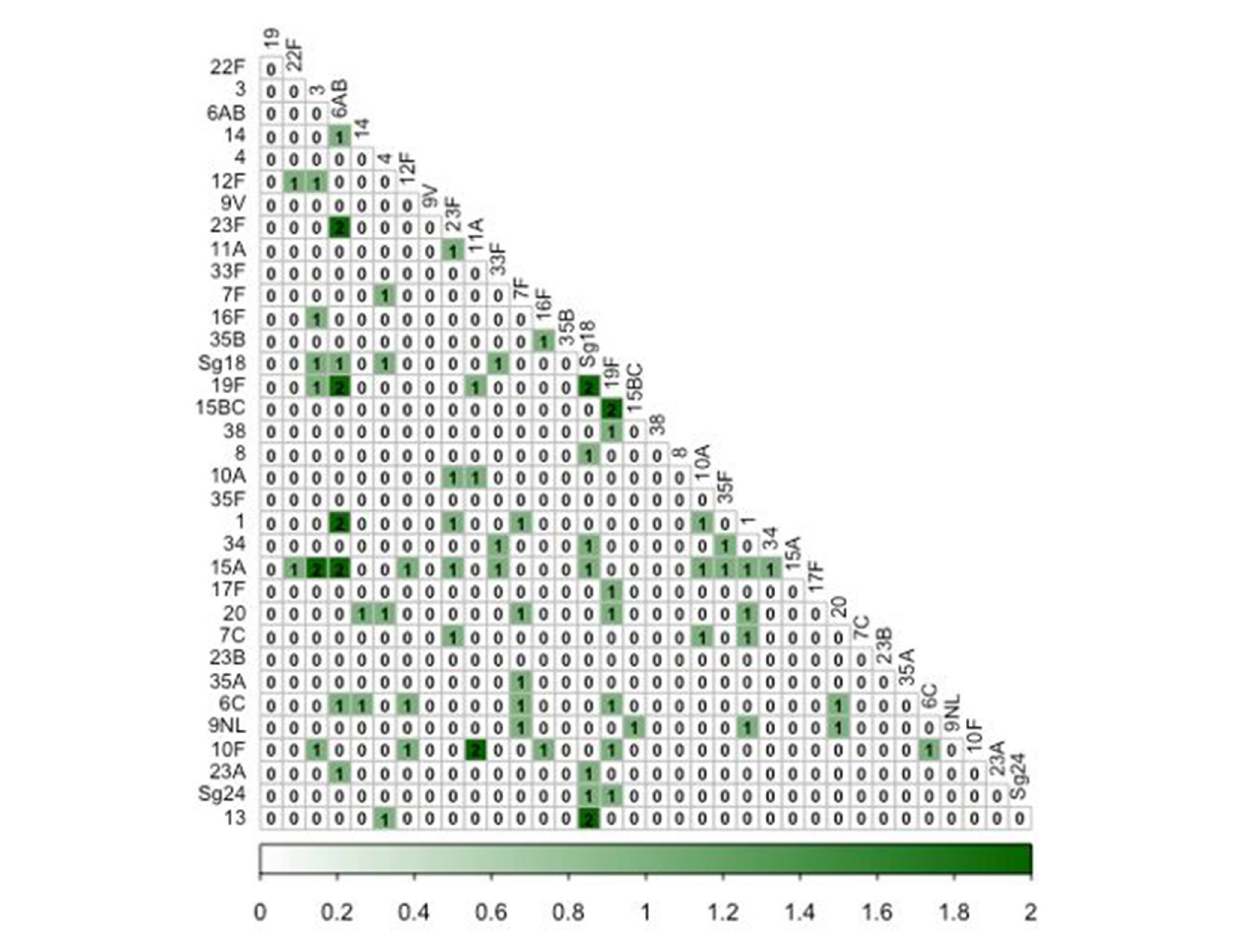
FIGURE3 Co-occurrence matrix of pneumococcal serotypes among influenza-like illness cases. Numbers within cells represent the number of ILI episodes in which each pairwise combination of serotypes was